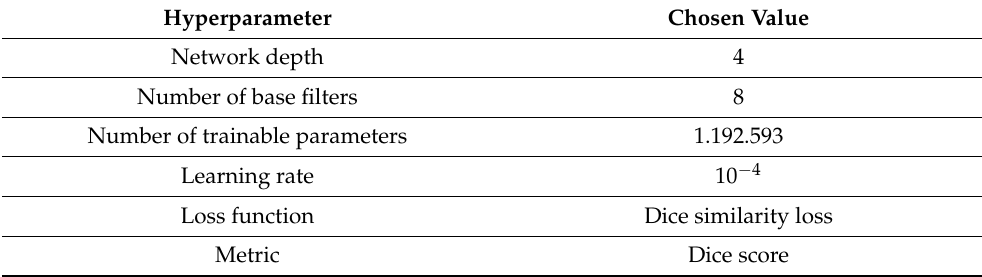
Table 2. Hyperparameters of the VNet-T2